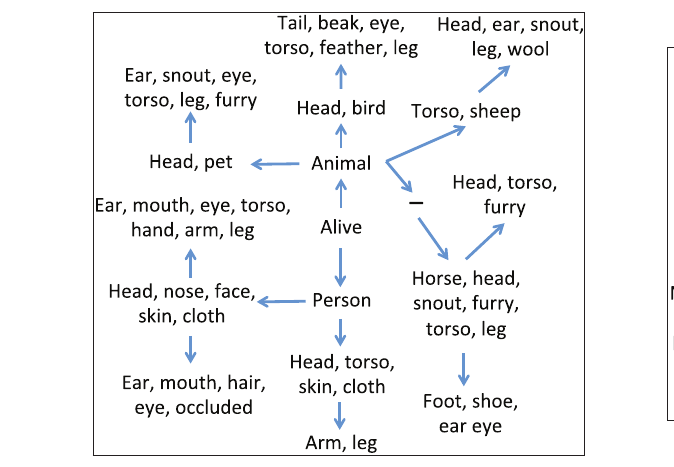
corresponds to the “living things” domain, whereas the right panel corresponds to the “transportation” domain. The sign ( − ) denotes an internal node.